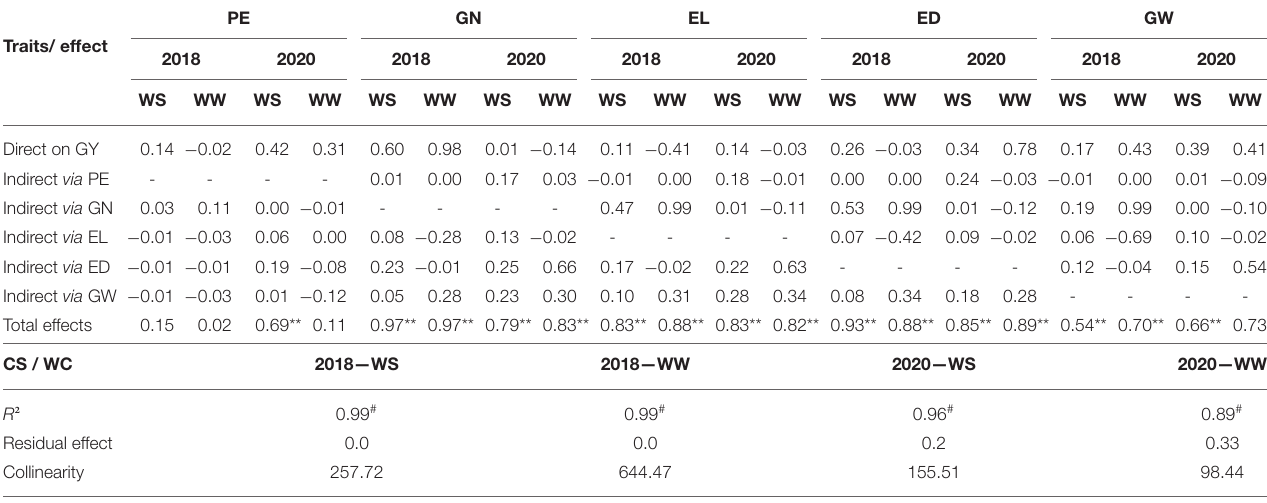
TABLE 6 | Path analysis of the partitioning of genotypic correlations into components of direct and indirect effects, a collinearity test, coefficient of determination, and residual effect obtained between GY and agronomic traits evaluated in popcorn genotypes under WS and WW conditions in the crop seasons of 2018 and 2020.